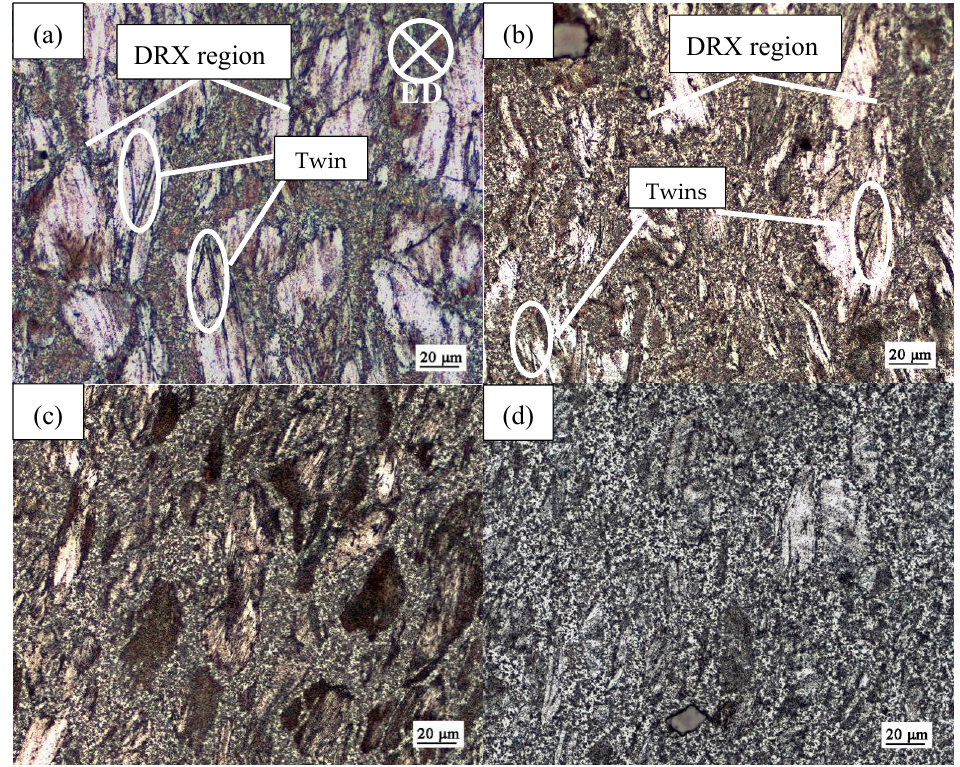
Figure 6. Microstructure of different passes at the temperature of 240 °C with different strain percentage: ( a ) backward extrusion, ( b ) extension with 43.8% area reduction, ( c ) extension with 64.0% area reduction, ( d ) extension with 91.0% area reduction.